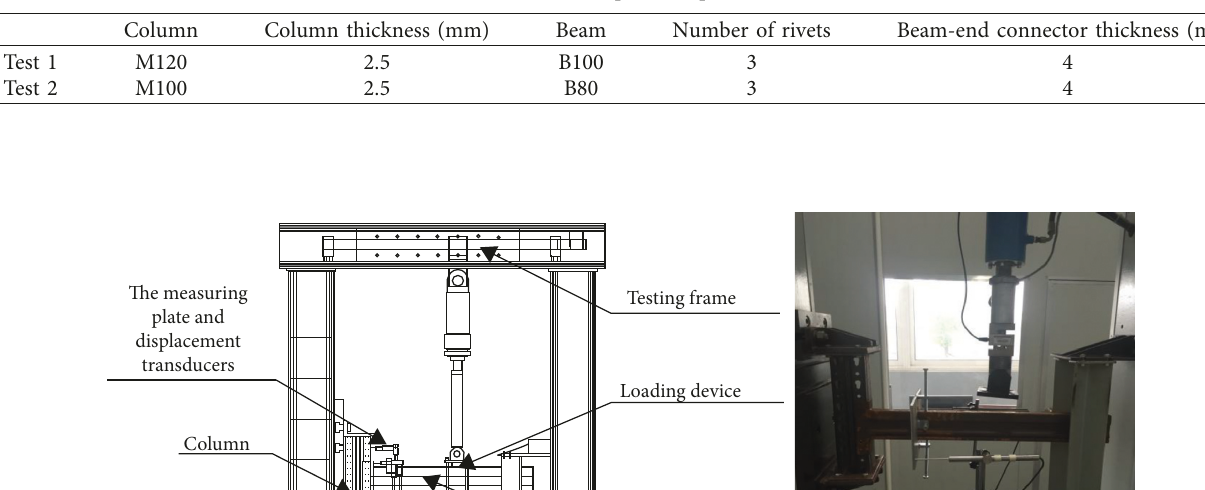
Table 2: Detailed specimen parameters.